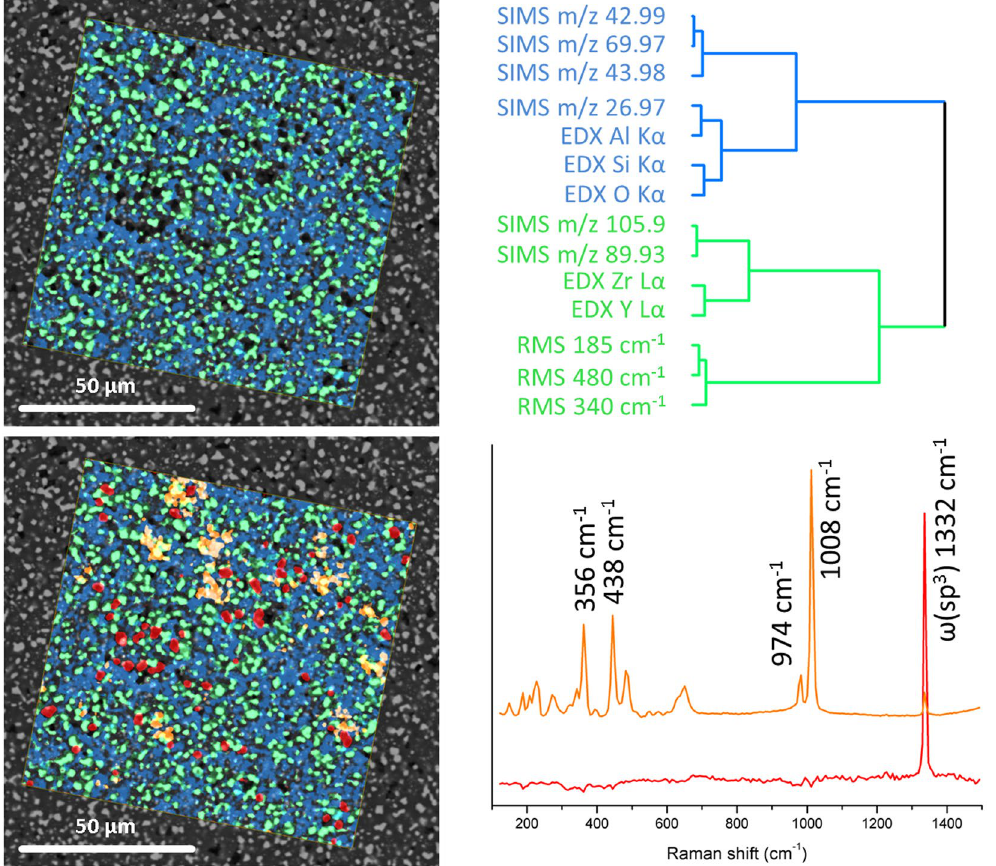
Figure 4. Superposition of the SEM image of the ceramic mullite/ZrO 2 composite with the image of the HCA of the PCA loadings (upper part) and with the extracted endmembers of the VCA (lower part), which represents the diamond Raman spectrum (red) and the ZrSiO 4 Raman spectrum